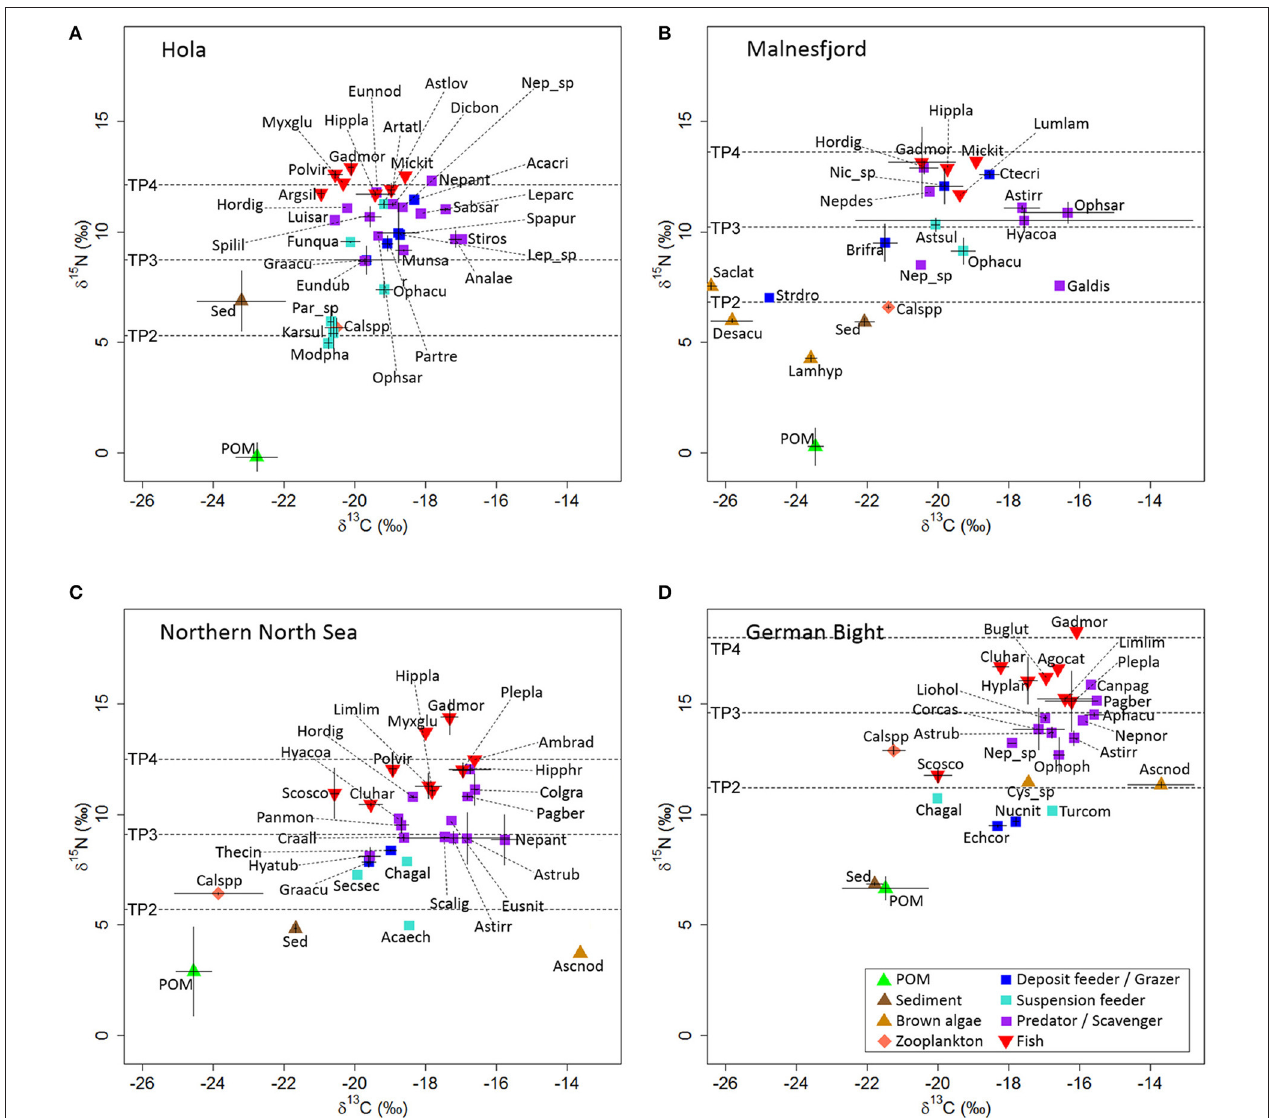
FIGURE 2 | Mean δ 13 C ± 1 SD and mean δ 15 N ± 1 SD at all study locations: Hola (A) , Malnesfjord (B) , northern North Sea (C) , and the German Bight (D) . Labeling according to taxon code shown in Table 1 . Red algae ( Ptilota gunneri [ δ 13 C: − 35.7 ± 0.0, δ 15 N: 6.3 ± 0.0]; Odonthalia dentata [ δ 13 C: − 32.7 ± 0.5, δ 15 N: 5.4 ± 0.5]) and identified outliers ( Thyasira sp. [ δ 13 C: − 35.2 ± 0.6, δ 15 N: − 5.3 ± 0.5]; Nephtys sp. [ δ 13 C: − 29.4, δ 15 N: 2.1]) are not shown for Malnesfjord.